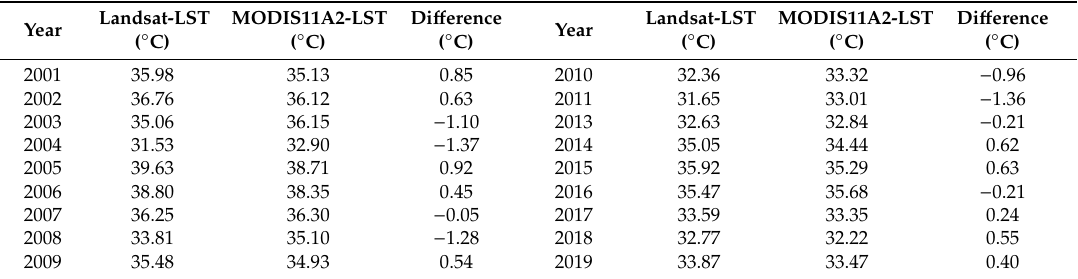
Table 3. The comparison of mean LST from Landsat and MODIS11A2 from 2001 to